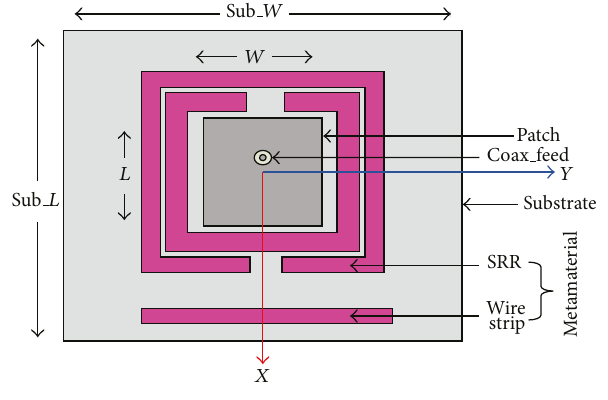
Figure 8: Metamaterial based microstrip patch antenna.